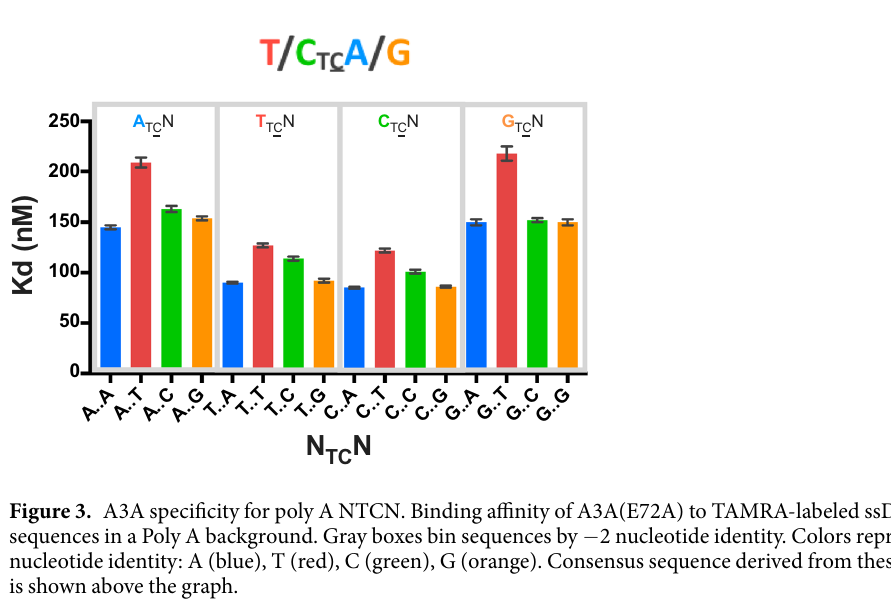
Figure 2. A3A specificity for nucleotides flanking substrate cytidine. Fluorescence anisotropy of TAMRA- labeled ssDNA sequences to A3A(E72A). ( a ) Binding of A3A to ssDNA with changes at − 1 position of substrate C in a poly A background (12 mers): 4A-AC-6A (blue), 4A-TC-6A (red), 4A-CC-6A (green), and 4A-GC-6A (orange). ( b ) Binding of A3A to ssDNA with changes at − 2 position in a TC context in a Poly A background (12 mers): 4A-ATC-6A (blue), 4A-TTC-6A (red), 4A-CTC-6A (green), and 4A-GTC-6A (orange). ( c ) Binding of A3A to ssDNA with changes at + 1 position in a TC context in a Poly A background (12 mers): 4A-TCA-6A (blue), 4A-TCT-6A (red), 4A-TCC-6A (green), and 4A-TCG-6A (orange). ( d) Three substrate sequences, TTCA (green), ATCG (red) and ATCA (blue), in closed circles with the corresponding 3 product sequences TTUA (green), ATUG (red) and ATUA (blue) in open circles.